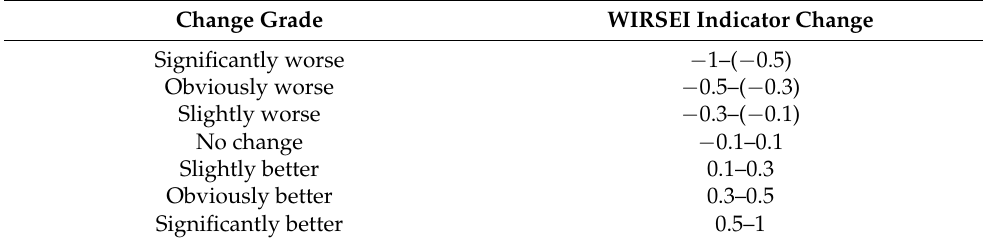
Table 5. Change in the ecological index